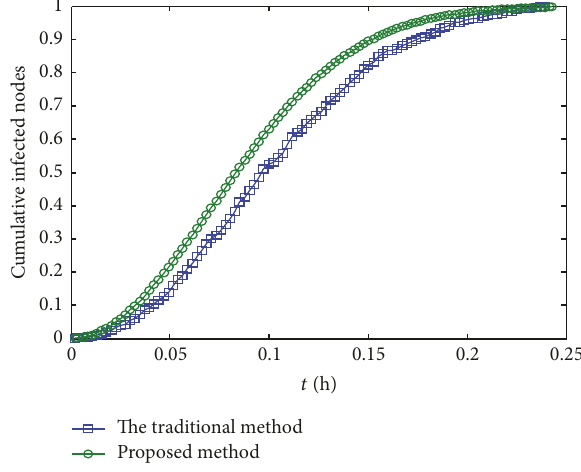
Figure 9: Cumulative infected nodes and